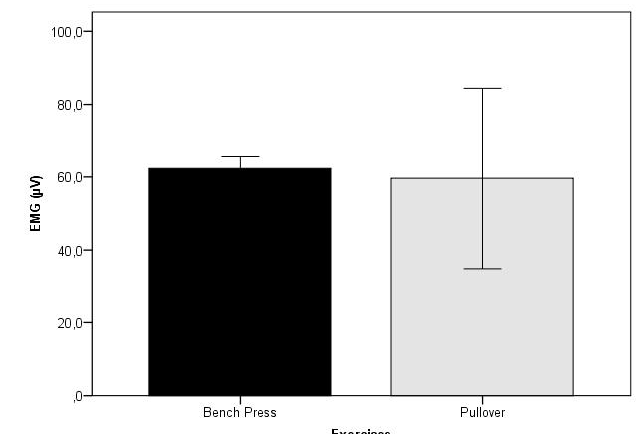
Figure 5. Comparison of electromyographic activation of posterior deltoid between horizontal bench press and barbell pullover exercises (mean and SD).